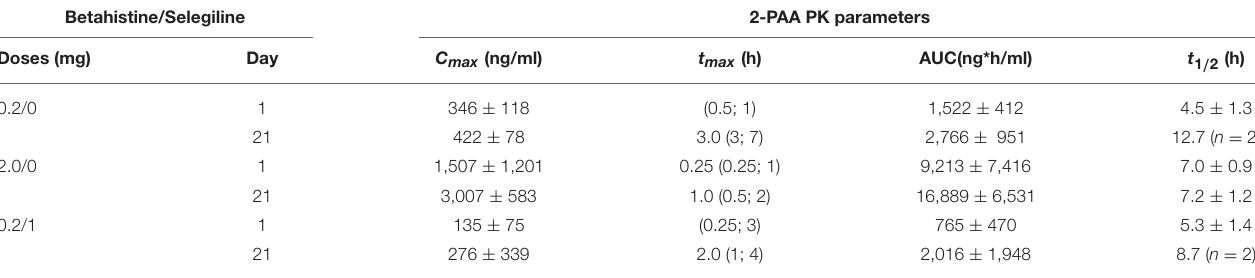
TABLE 2 | 2-PAA PK parameters following administration of different doses of betahistine and co-medication of betahistine with the MAO-B inhibitor selegiline.